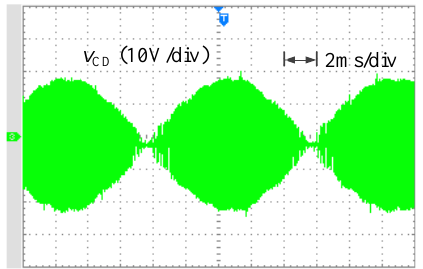
Figure 22. The experimental result of the transformer secondary voltage v CD ( ϕ 1 = π /2, θ = π /2).